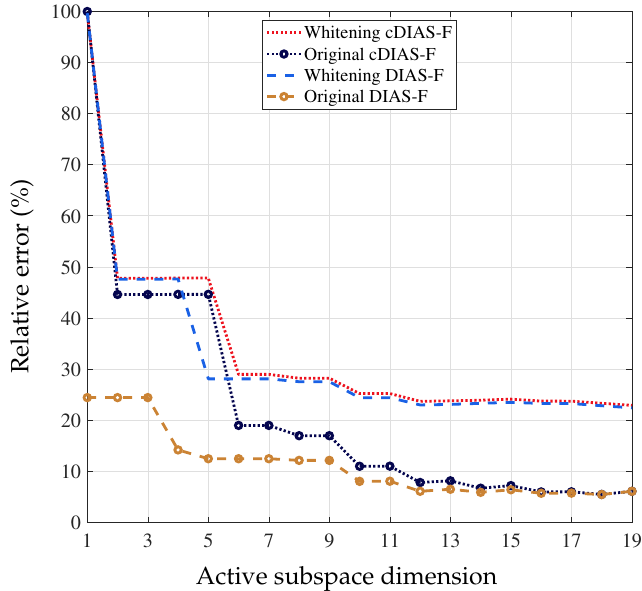
Figure A1. The relative error of original active subspace and whitened active subspace in the overregularization